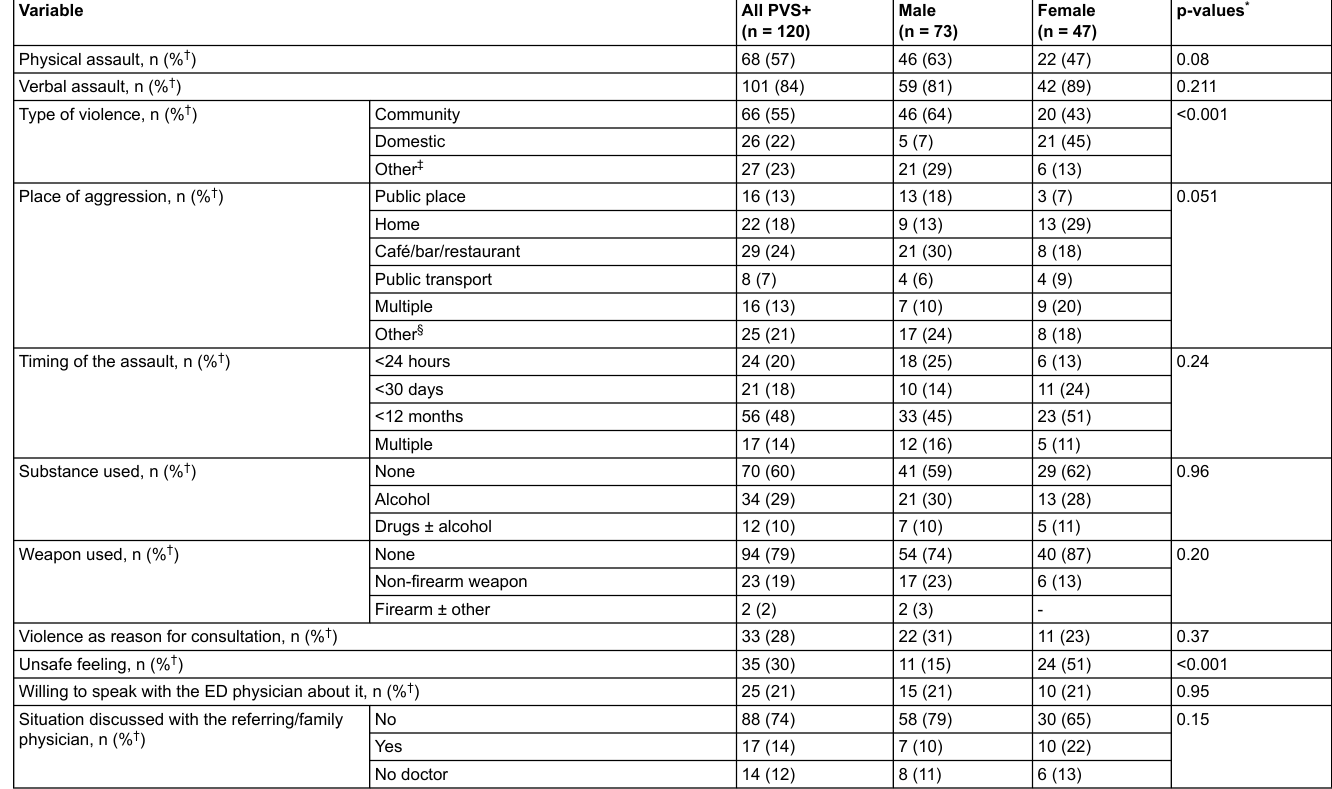
Table 3: Assault characteristics described by patients, differentiated by